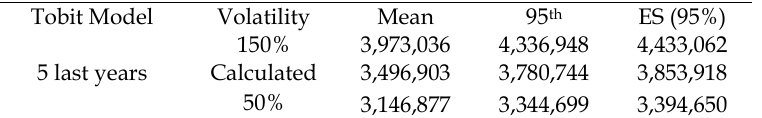
Table 8. Sensitivity Daily Delays to Tobit volatility in 2019 Tobit